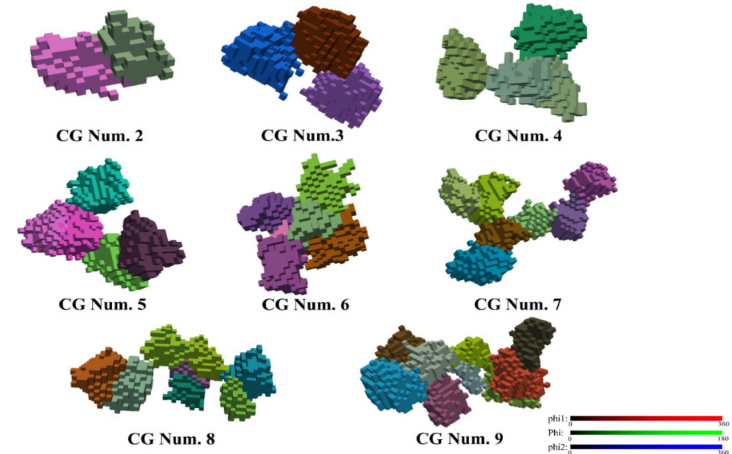
Figure 13. Typical morphologies for grain coalescence at a shear strain of 2. Note that the deformation- induced grain shape change is not displayed; the grains are represented in their initial form. The colors refer to the Euler angles. CG Num. indicates the number of coalescing initial grains.